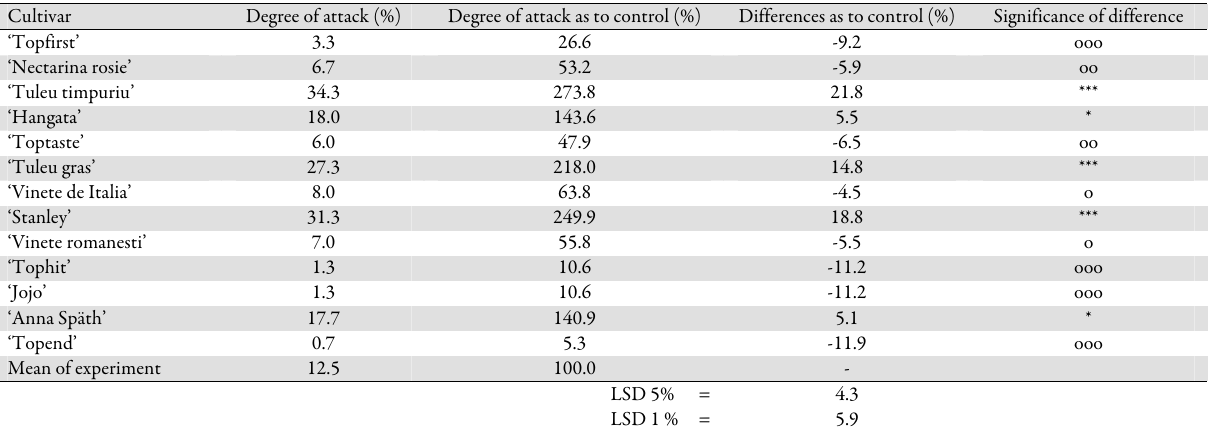
Table 1. The response of plum cultivar to leaf blister ( Monilinia laxa ) attack on fruits, under natural infection